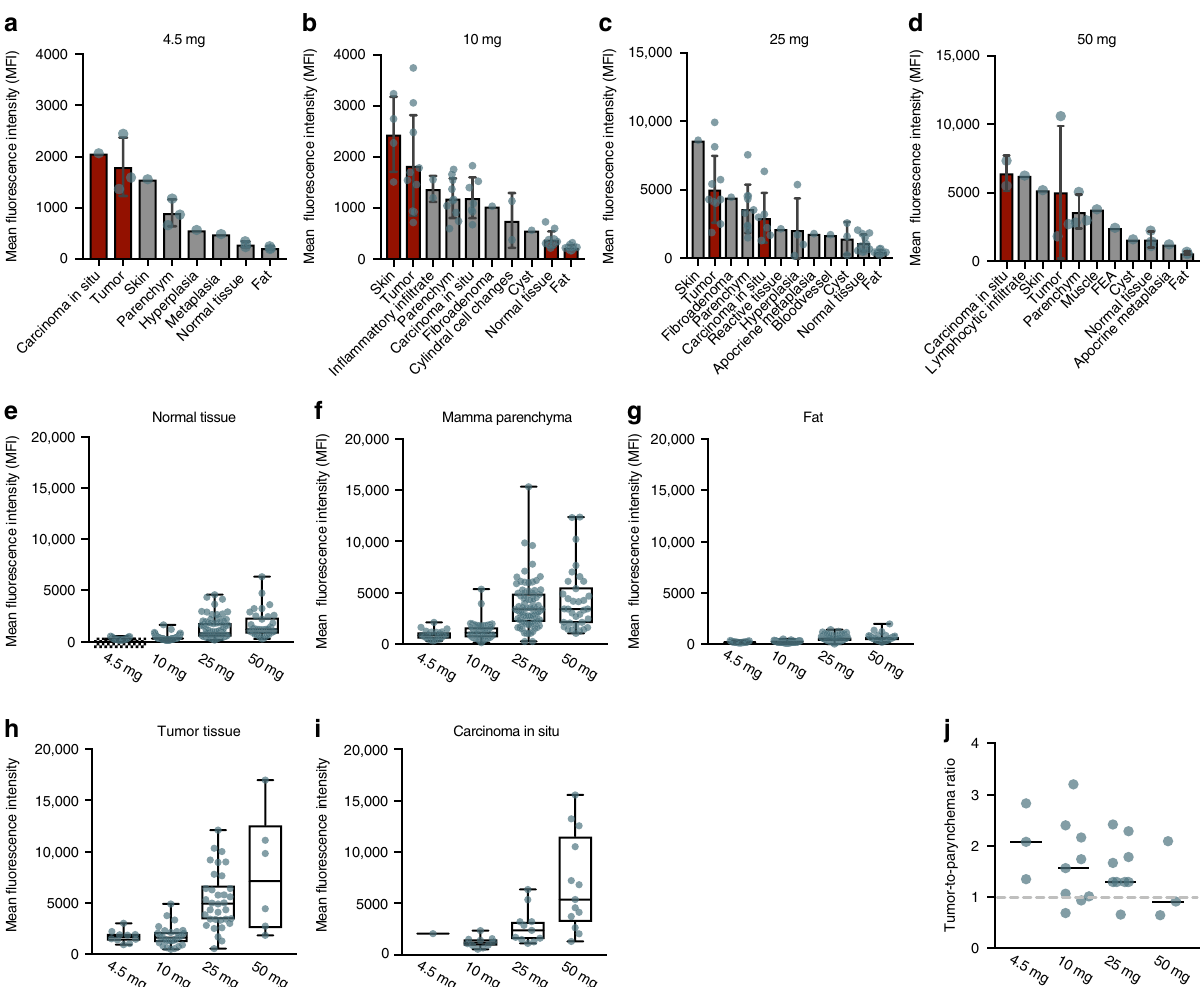
Fig. 4 Micro-segmentation per dose group, and per tissue type. Per dose group we plotted mean fl uorescence intensity per tissue type ( a – d ); tumor and carcinoma in situ components shown in red. The mean fl uorescence intensity per tissue type was plotted in e - i . In j the tumor-to-parenchyma ratio per dose group is plotted. Bars represent the mean and the error bars the standard deviation. Boxplot centerline is at median, the bounds of the box at 25th to 75th percentiles, the whiskers are depicting the min –